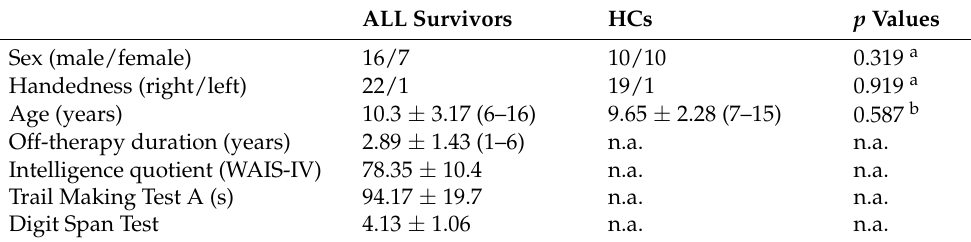
Table 1. Demographic and clinical characteristics of the young survivors of ALL and HCs. ALL Survivors HCs p